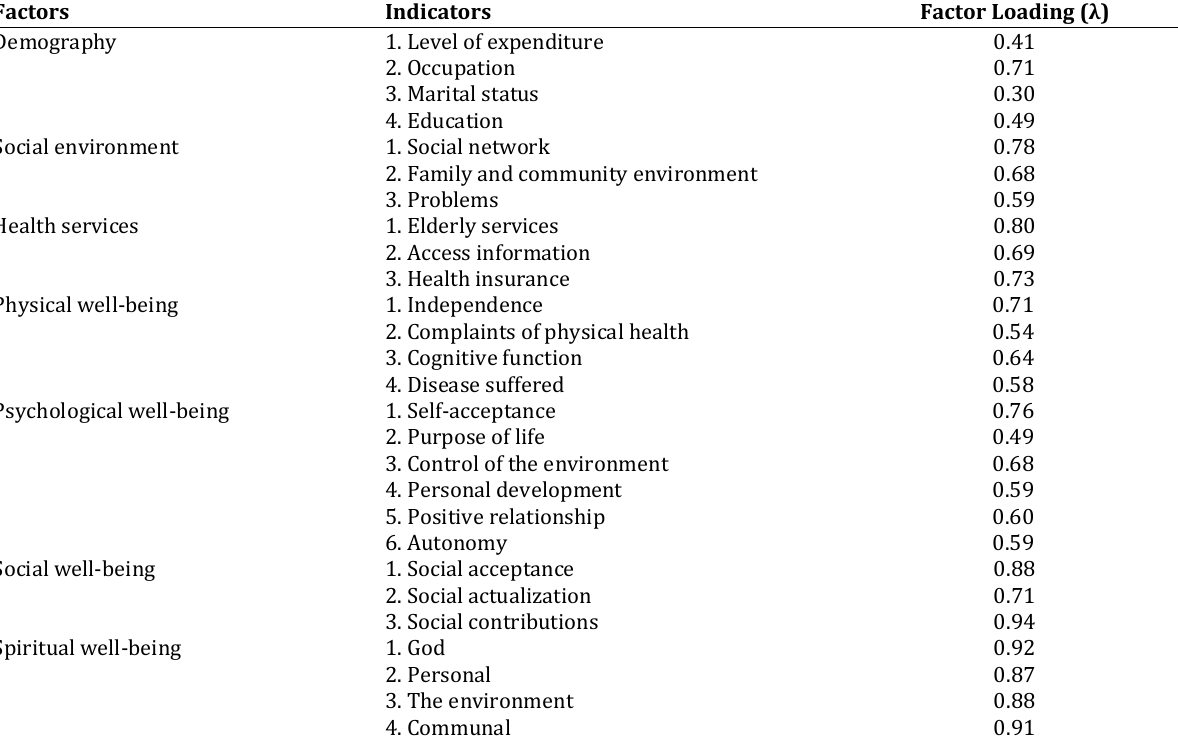
Table 2. Well-being Indicators based on Loading Factor Factors